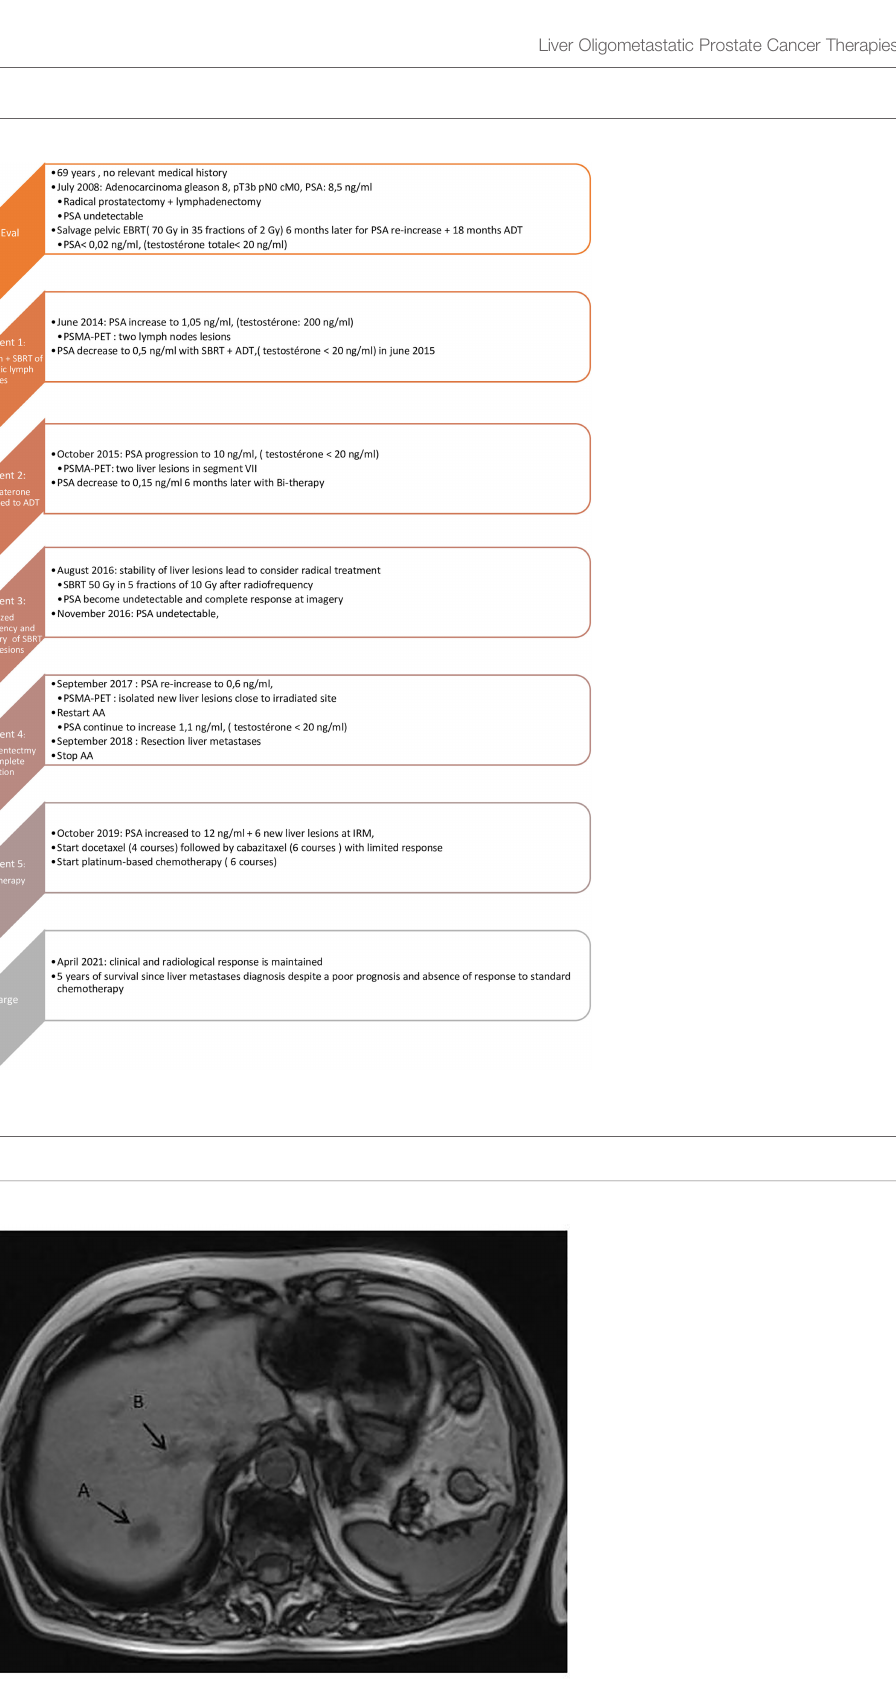
FIGURE 2 | MRI liver revealed two metastases: (A) in segment VII and (B) straddling segments V and